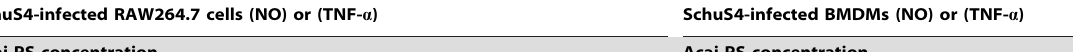
Table 2. Acai PS induces TNF- a and NO in type A F. tularensis -infected RAW264.7 cells, but not in murine BMDMs.